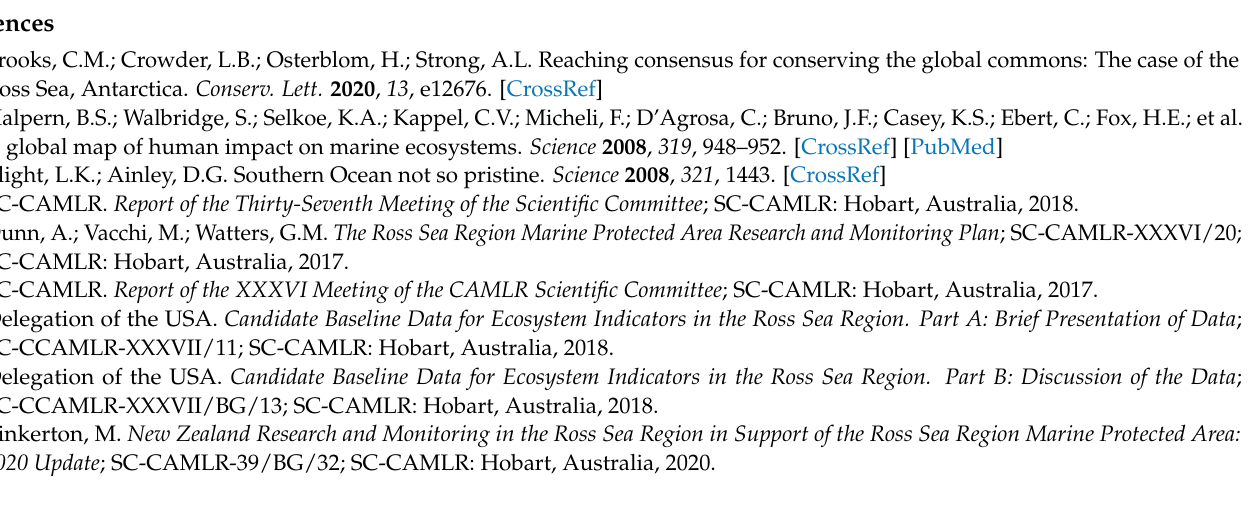
Table S1: Research and monitoring topics that are directly relevant to the Ross Sea region marine protected area (see Figure 1 for map), address core questions in the research and monitoring plan, and emphasize work throughout the geographic areas in the Ross Sea region (modified after Dunn et al., 2017), Table S2: Currently progressing Ross Sea projects relevant to the Ross Sea marine ecosystem (funded by NSF or NASA). Projects grouped according to topical areas., Table S3: Papers with